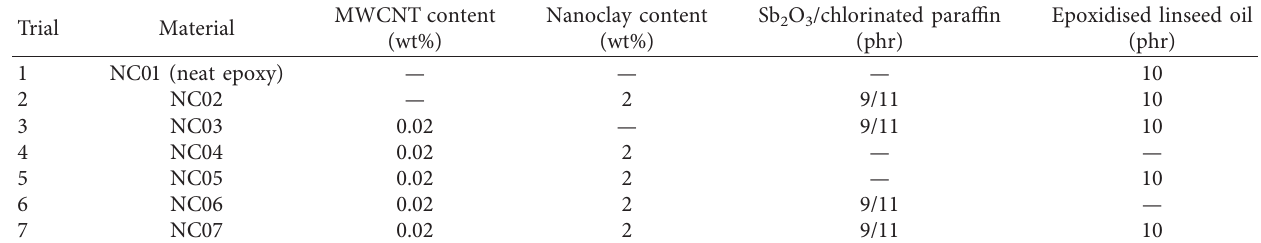
Table 4: Taguchi orthogonal array of designed experiments based on the coded levels.